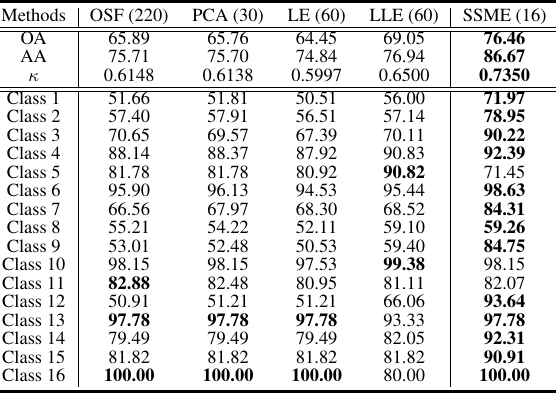
Table 2. Classification performance comparison between different algorithms on the Indian Pines dataset. The best results are shown in bold. Furthermore, the values behind the name of algorithms mean the dimensions used in these compared